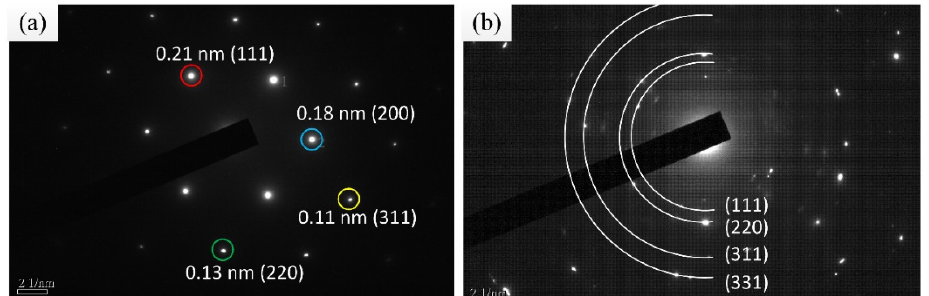
Figure 12. TEM diffraction pattern and corresponding Miller indices: ( a ) Cu, ( b ) diamond.